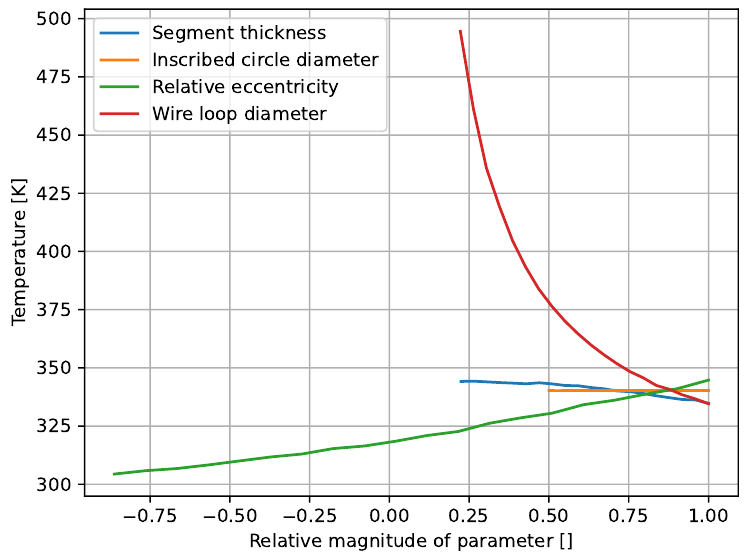
Figure 6. Maximum temperature vs. relative magnitude of all parameters in the case of a thin ice layer on the matrix